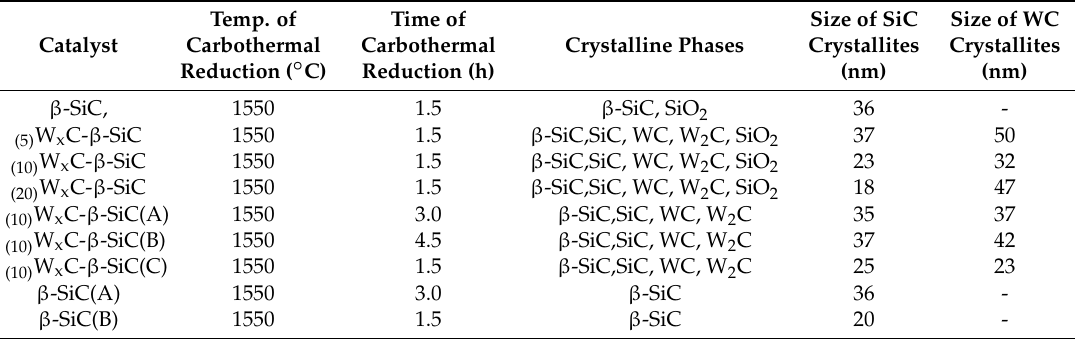
Table 2. Average crystallite size in WxC- β -SiC-type nanocomposites.